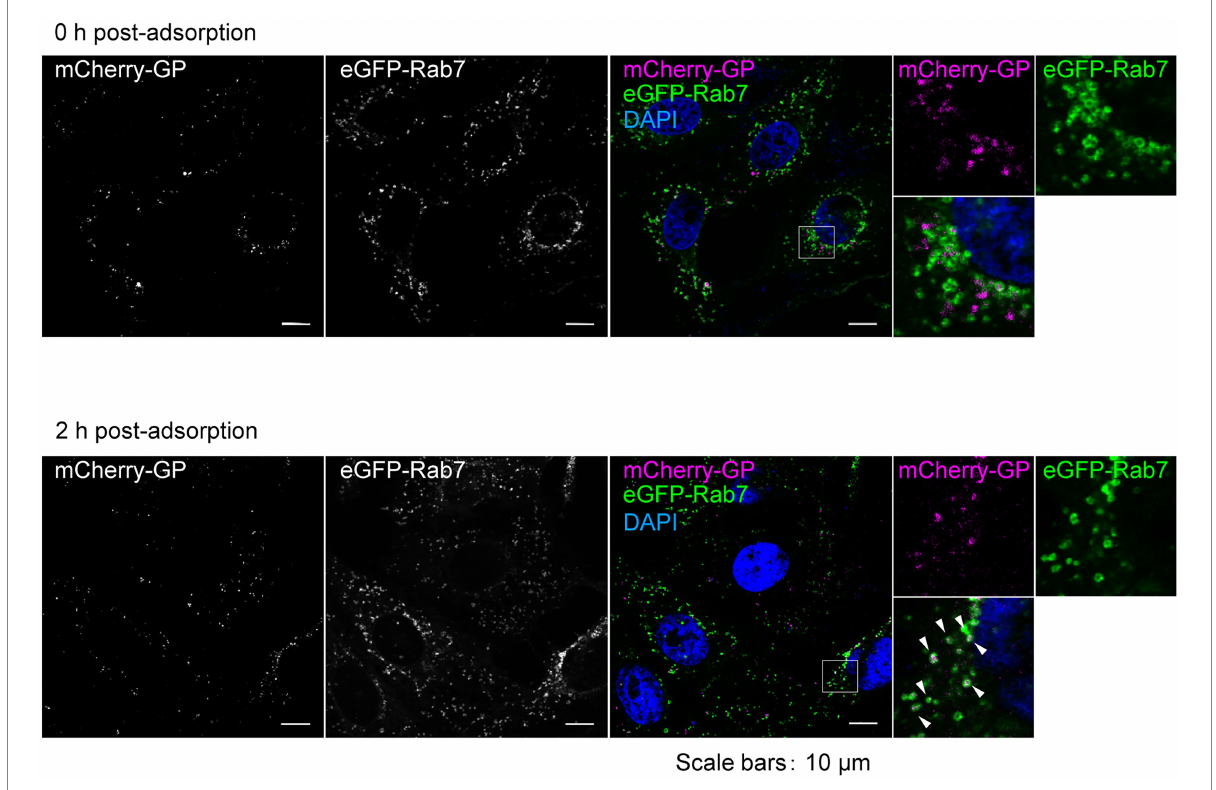
FIGURE 4 Visualization of entry process of trVLP-mCherry-GP into recipient cells. trVLP-mCherry-GP was inoculated into Vero E6 cells expressing eGFP- Rab7 and incubated for 30 min on ice. After adsorption, cells were incubated for 0 h (top) or 2 h (bottom) at 37 ° C. The distribution of mCherry signals (left) on the cell surface (0 h, top), in the cytoplasm (2 h, bottom), and in eGFP-Rab7 (middle) was analyzed by confocal laser scanning microscopy. mCherry-GP and eGFP-Rab7 are shown in magenta and green, respectively, in the merged image. The insets show boxed areas. The white arrows represent colocalized signals. The nuclei were counterstained with DAPI (blue in the merged images). Scale bars: 10 μ